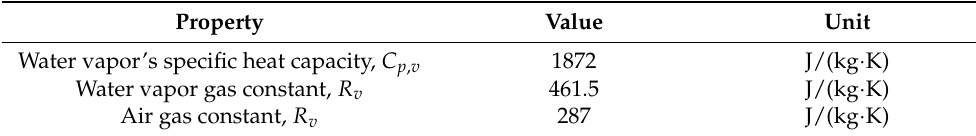
Table 4. Air and water vapor constant